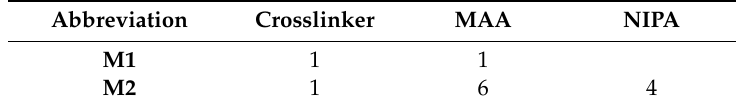
Table 1. Molar ratios of monomer units in the different macromers.